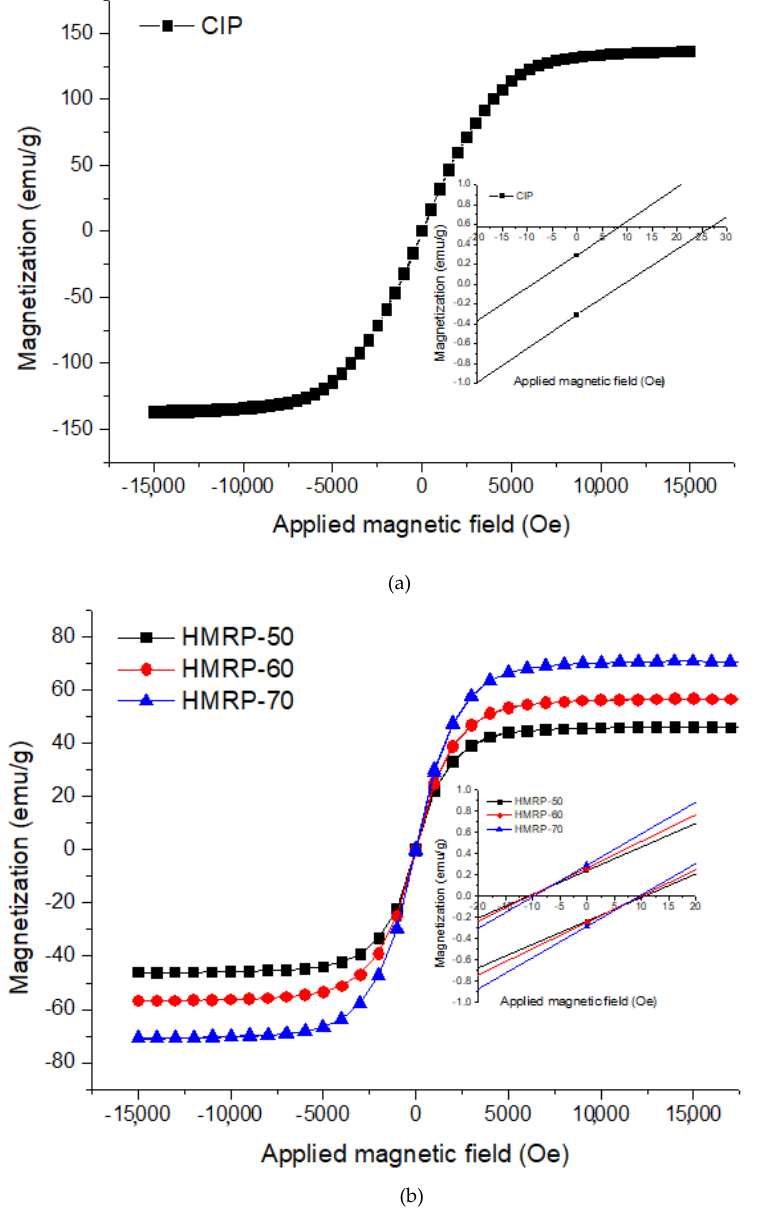
Figure 1. Magnetization curves of ( a ) bare carbonyl iron particles (CIPs) and, ( b ) polyvinyl alcohol hydrogel magnetorheological plastomer (PVA HMRP) samples with different CIPs content.